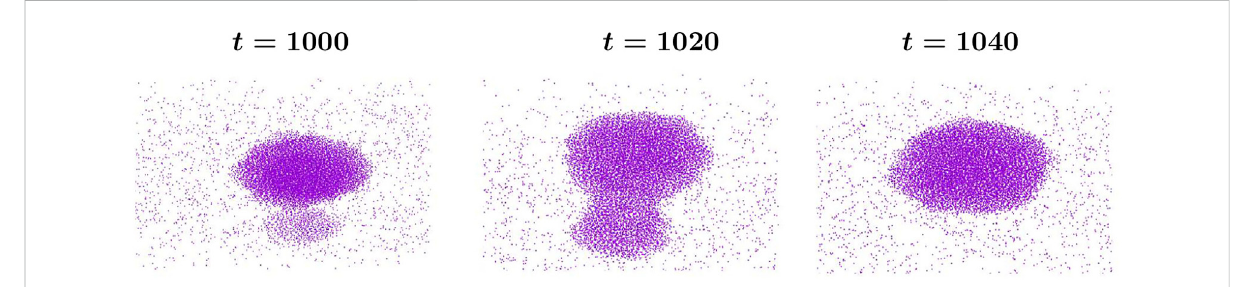
FIGURE 3 Molecular dynamics simulation snapshots of a coalescence event at different times t expressed in units of τ 0 . See main text for the de fi nition of τ t =1000, a thin liquid bridge forms and evolves with time until a single product drop forms at t =1040, in the 0 . Two droplets touch at time background of the low-density vapor phase. System size and temperature are L =100 and T =0.68 T c , respectively. Phase separation progresses via the coalescence of liquid